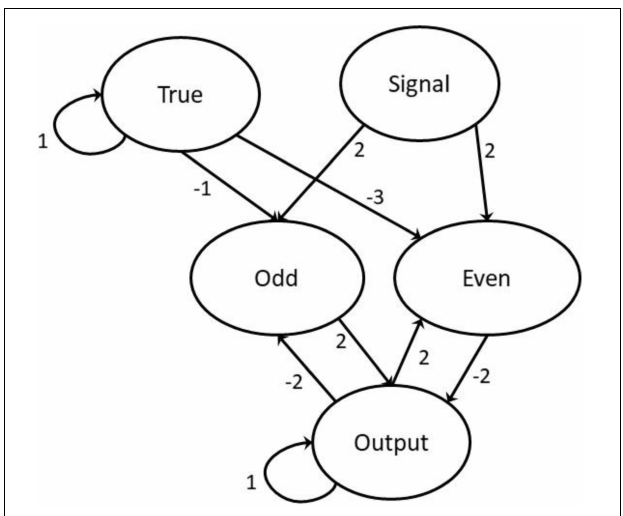
FIGURE 2 | The neural network with weightings marked with directed